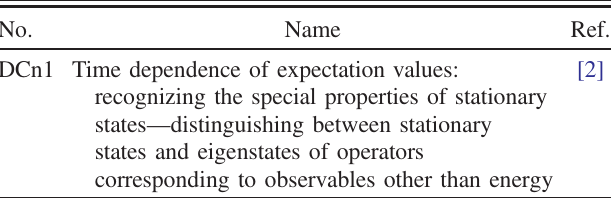
TABLE X. Difficulties that exhibit both displacement and content errors in simpler problems. This difficulty is labeled DC for displacement and content errors and n because the problem does not require shifting.